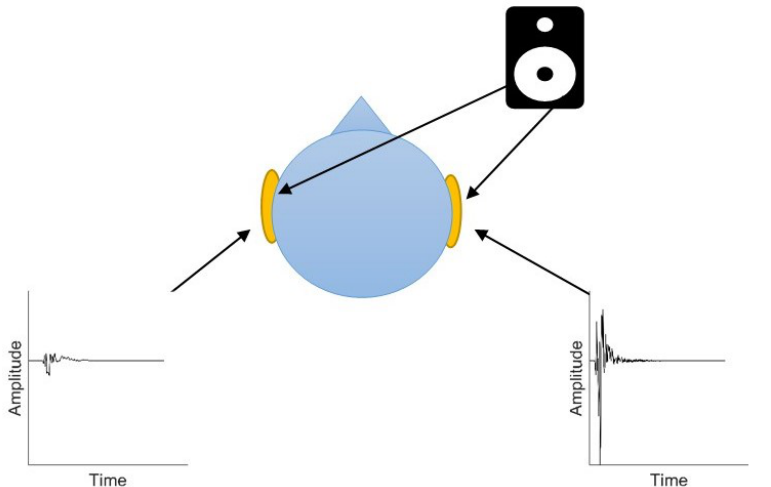
Figure 1. Binaural cues for horizontal localization. Plots display two time-domain representations of Head Related Transfer Functions (HRTF) recordings (45 ◦ azimuth & 0 ◦ elevation) extracted from the SADIE Database [27]. Reprinted with permission from